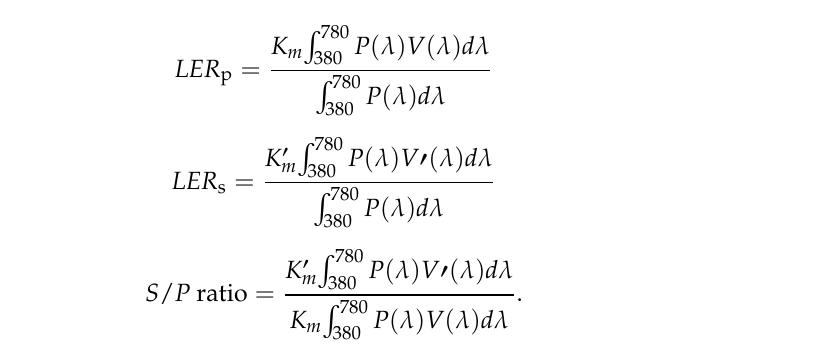
Figure 2. Scotopic / photopic ratios ( R sp ) as a function of wavelength using ( a ) 2-degree and ( b ) 10-degree SSCs. Some special R sp values have been marked. The R sp at 555 nm is equal to unity. The R sp values at 531.1 / 533.5 nm are 2.261 / 2.085, and are equal to those for equal energy white (EEW) light in the 2-degree/10-degree cases. ( c ) Comparison of S / P ratios using